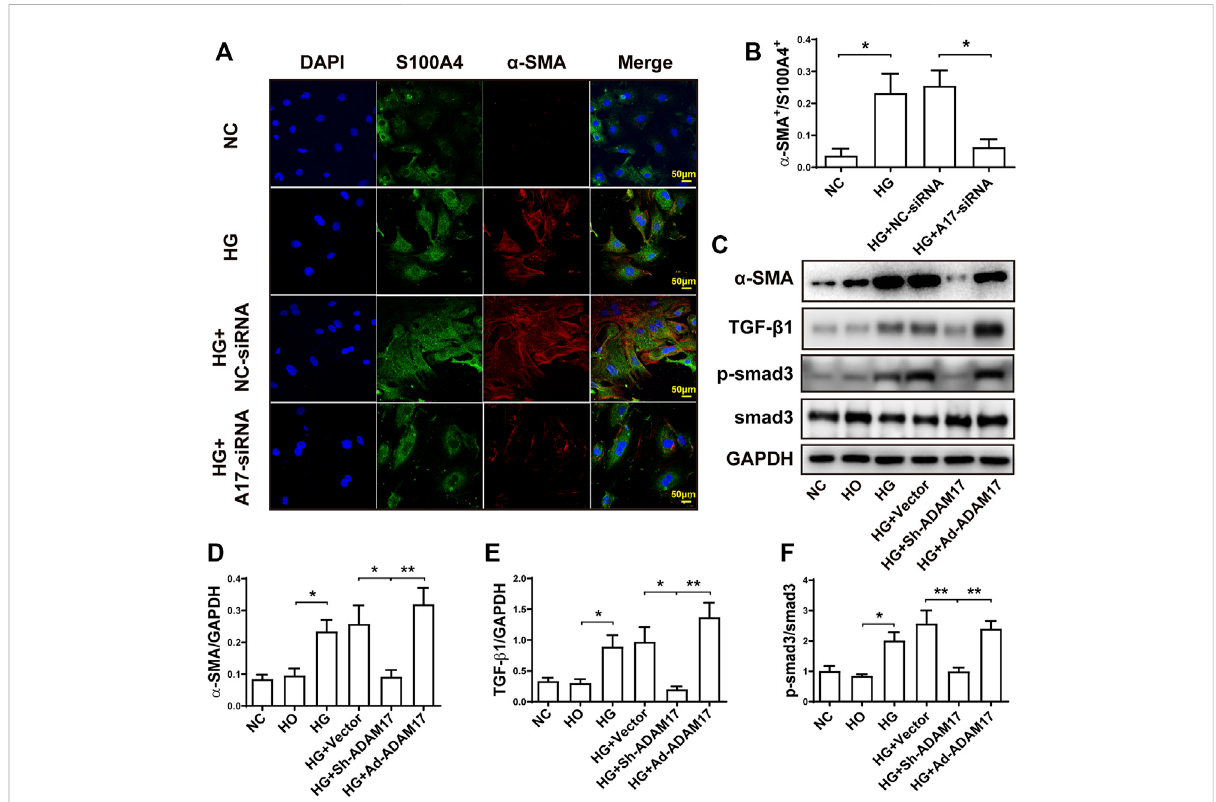
FIGURE 6 Comparison of α -SMA, S100A4, TGF- β 1 and Smad3 in primary cardio fi broblasts. (A) Representative immunohistochemical staining of S100A4 and α -SMA (400x, scale bar: 50 μ m) in 4 groups of cardio fi broblasts. (B) Quanti fi cation of α -SMA + /S100A4 + ratio in 4 groups of cardio fi broblasts. (C) Representative Western blotimages of α -SMA,TGF- β 1,Smad3phosphorylationandSmad3in6groupsofcardio fi broblasts. (D) Quanti fi cation of α -SMA protein expression in 6 groups of cardio fi broblasts. (E) Quanti fi cation of TGF- β 1 protein expression in 6 groups of cardio fi broblasts. (F) Quanti fi cation of Smad3 phosphorylation level in 6 groups of cardio fi broblasts. Data were expressed as the means ± SEM. * p < 0.05, ** p < 0.01, *** p < 0.001. n = 6 per